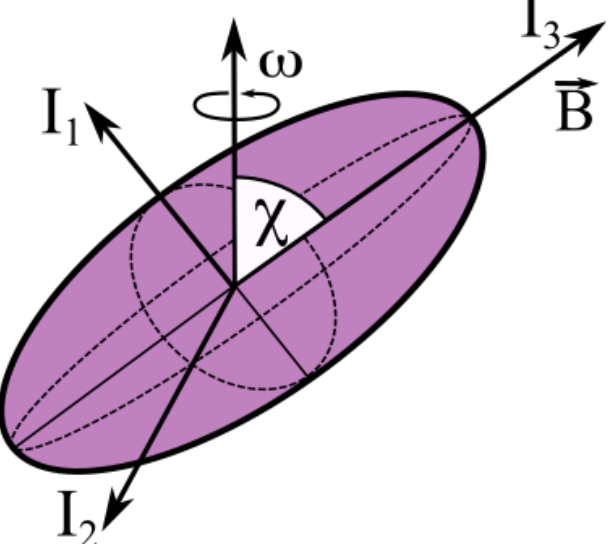
Figure 5. A model of the CGWs emission due to the magnetic deformation. The angle χ measures the misalignment between the magnetic field axis and rotation axis. In principle for χ (cid:54) = 0, CGWs emission will be produced even if I 1 = I 2 . Note that on this schematic picture (cid:126) B represents the dominant toroidal field, reflecting the fact that NS shape is prolate along the magnetic